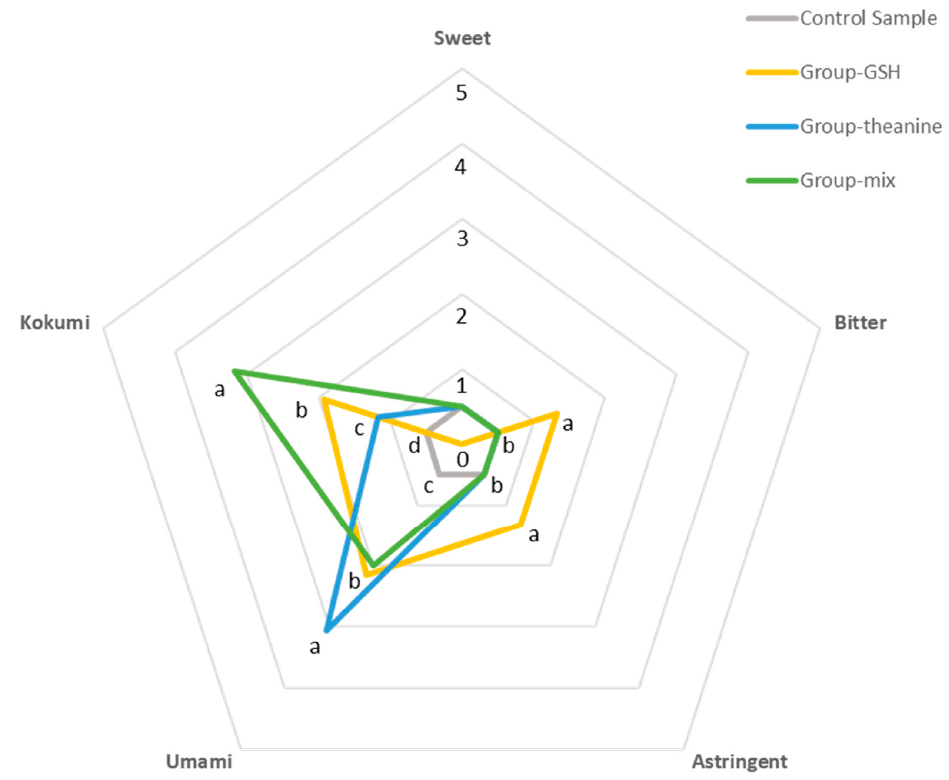
Figure 4. Spider plot of reconstituted samples.